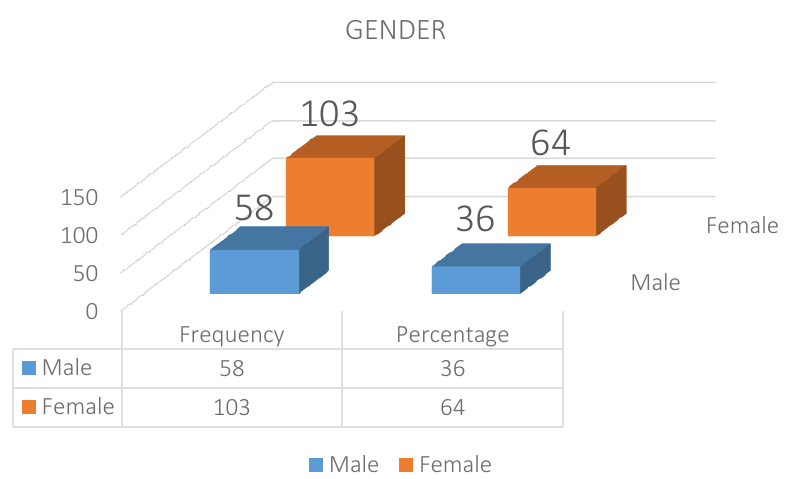
Figure 2. Gender of